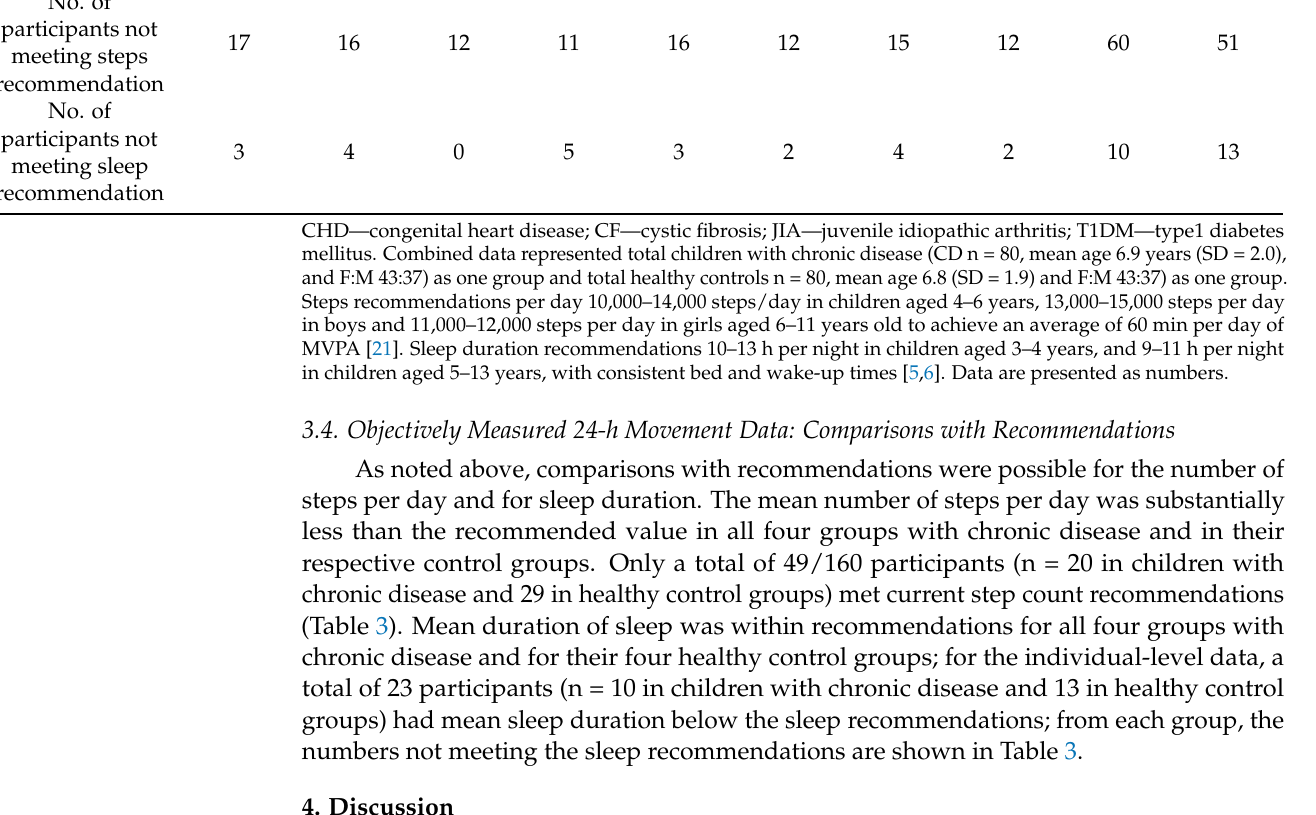
Table 3. 24-h movement behavior variables comparisons with recommendations in children with chronic disease and their healthy control groups; data are presented as numbers.